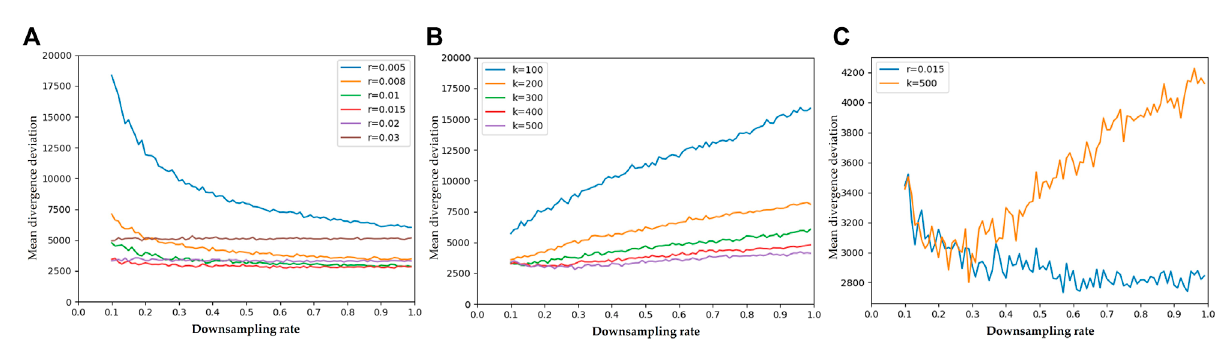
FIGURE 5 The results of the experiments to evaluate the accuracy of divergence solution. (A) : mean deviation of divergence using RNN neighbor search with various search radius r = [ 0 . 005 m , 0 . 03 m ] and downsampling rate r = [ 0 . 1 , 0 . 99 ] (B) : mean deviation of divergence using KNN neighbor search with various number of neighbors k = [ 100 , 500 ] and downsampling rate r = [ 0 . 1 , 0 . 99 ] (C) : comparison between the best results using RNN ( r = 0 . 015 m ) and KNN ( k = 500 ) .